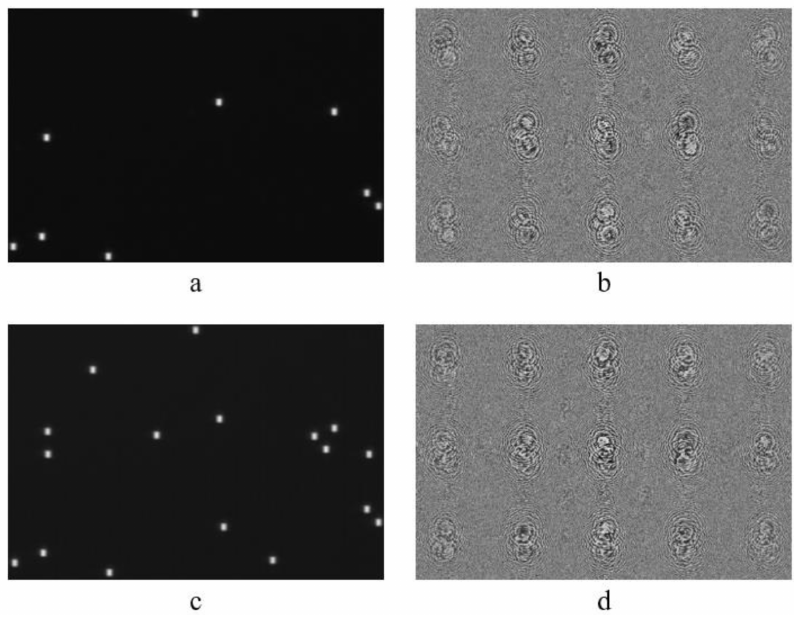
Figure 9. The encryption keys with NAE 0.0005 ( a ) and 0.001 ( c ) and corresponding DOEs ( b , d ). The number of incorrect pixels in the decrypted image was used as a measure of decryption error. The original images, encrypted images and keys were averaged over sixteen images to suppress noise. The images encrypted using the key with NAE 0.0005, and corresponding decrypted images are shown in Figure 10.